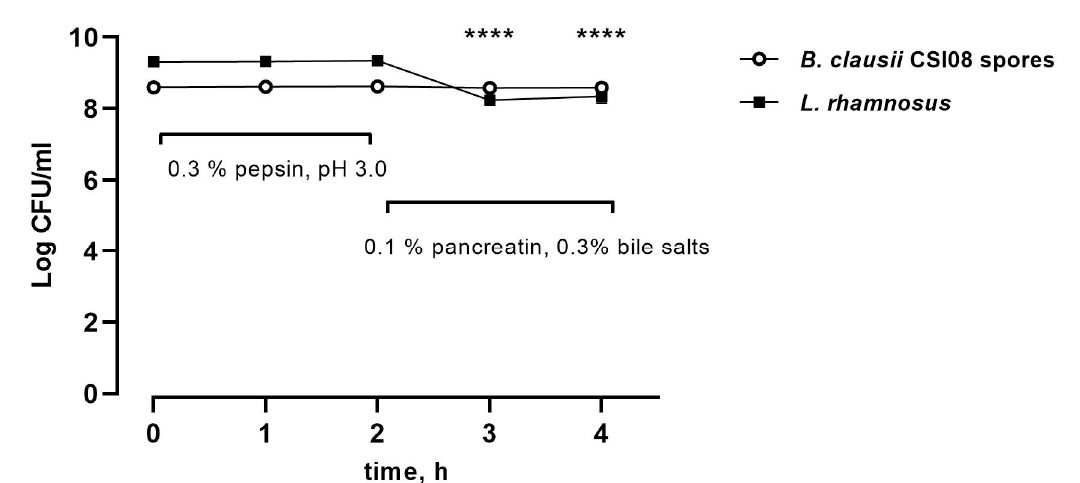
Figure 1. Survival of B. clausii CSI08 spores and L. rhamnosus ATCC 53103 at gastric and small intestinal digestion conditions simulated in vitro. The values are expressed in Log10 CFU/mL. Data represent the mean (n = 8) ± SEM of two independent experiments performed in four technical replicates. **** p < 0.0001 Survival of L. rhamnosus compared to 0 h.